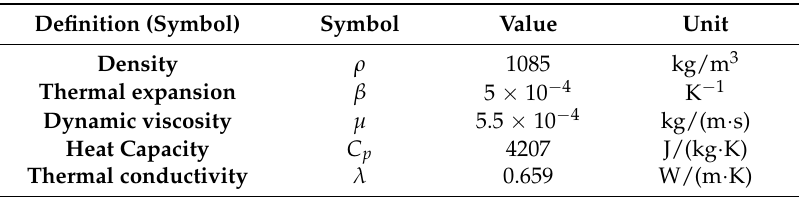
Table 1. Material properties of the heavy water.